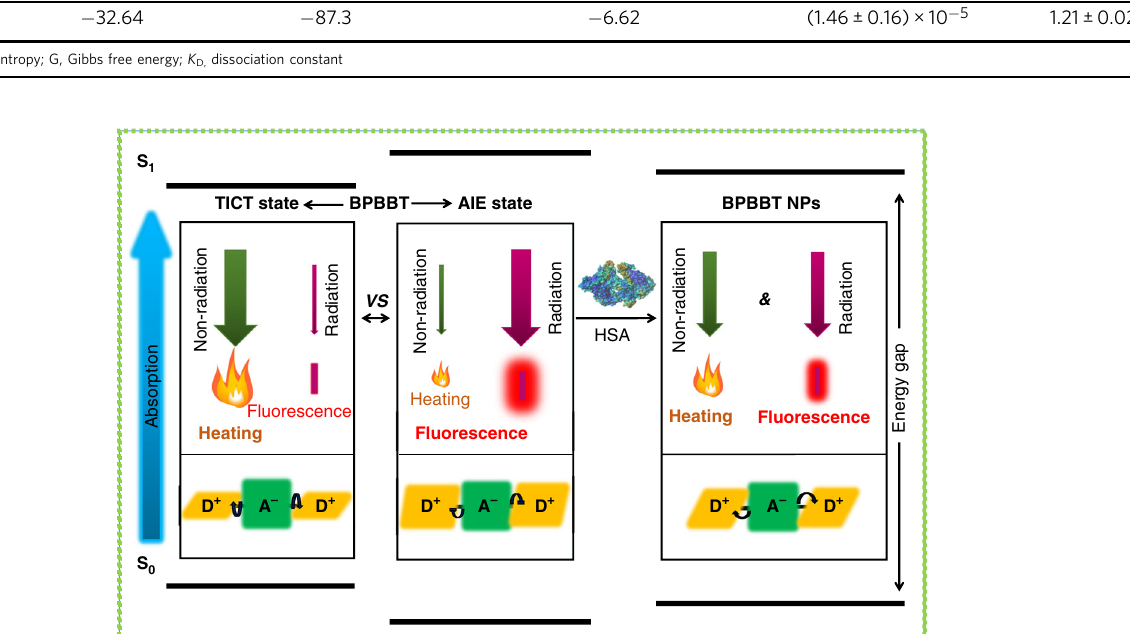
Fig. 3 Diagram. HSA altering fl uorescence and photothermal ef fi ciency of concentration-dependent manner (Supplementary Fig. 6a). The in vitro photothermal ablation effect of BPBBT NPs on CT26-Luc cells was also dependent on the nanoparticle concentration incubated and the laser dose applied (Supplementary Fig. 6b).